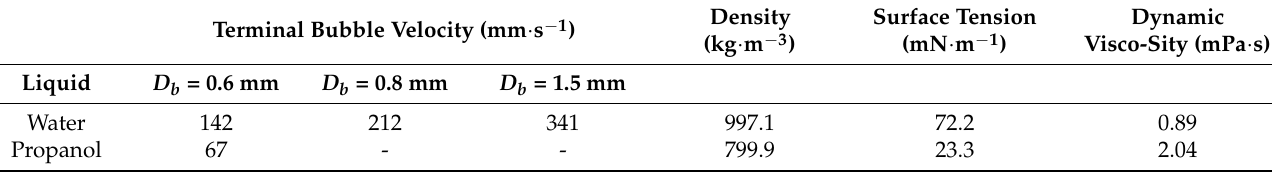
Visco-Sity (mPa · s)